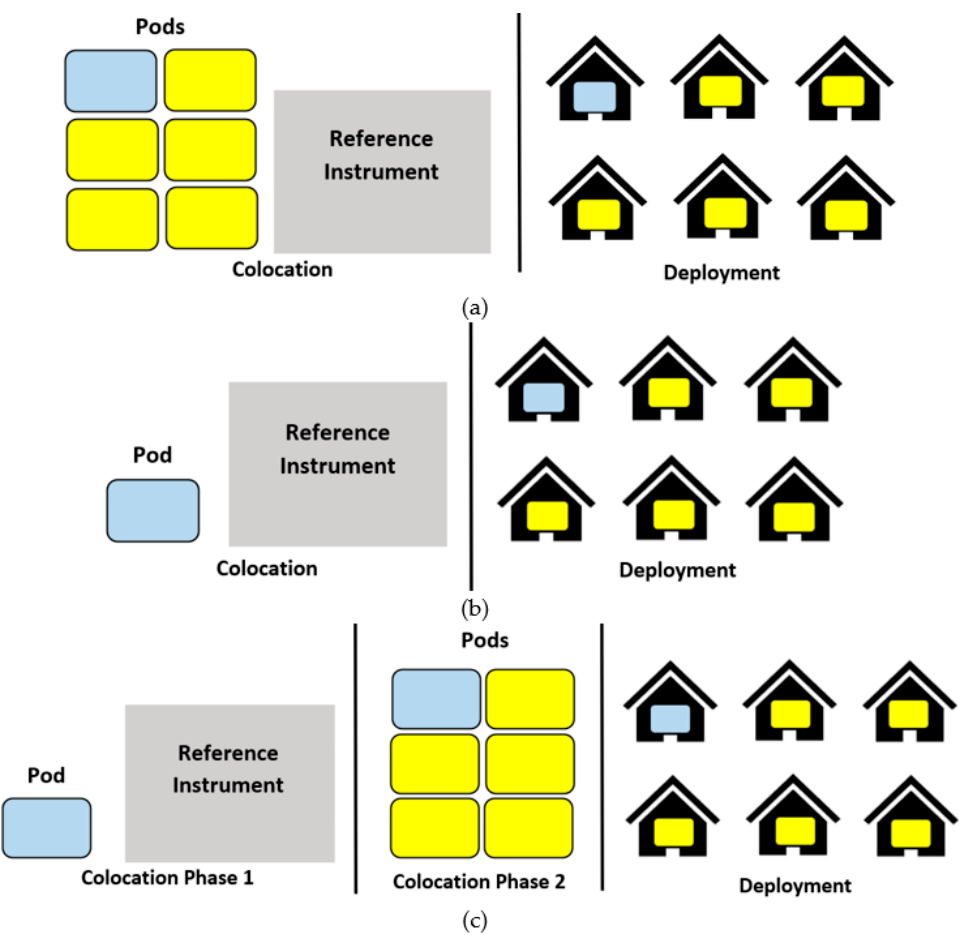
Figure 2. ( a ) Traditional co-location and deployment setup, used for the individual, z-scored individual, median, and sensor-specific normalization calibration approaches; ( b ) One-Cal method—generating one pod calibration model to apply to all pods; ( c ) One-Hop method—using one co-located pod as a reference to generate individual pod calibrations.